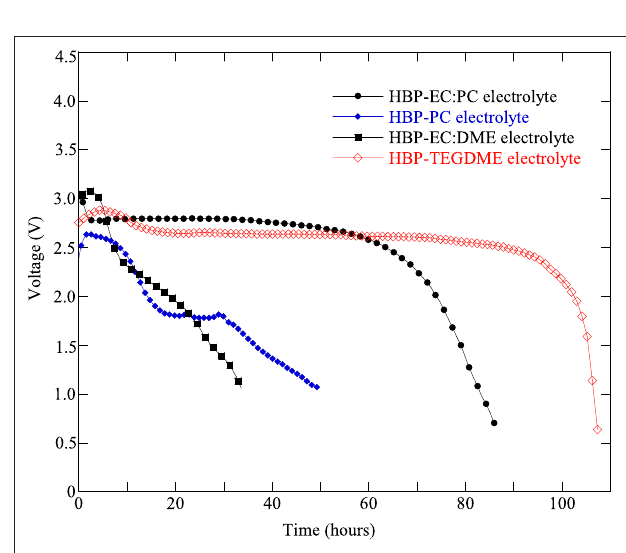
FIGURE 5 | Discharge profiles of fabricated Li-air battery cells at 0.1mA (equivalent to 50 mA/g) discharge current with different electrolytes: HBP with 1.0M LiTFSI in 1:1 EC:PC (Cell#51B), HBP with 1.0M LiTFSI in PC (Cell#51E), HBP with 1.0M LiTFSI in 1:1 EC:DME (Cell#59E), and HBP with 1.0M